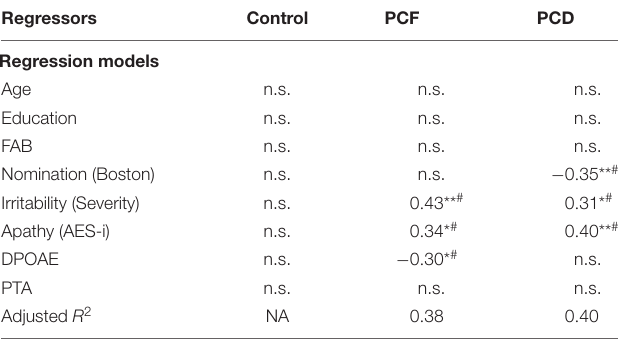
TABLE 3 | Determinants of functional impairment in the hearing status groups. Regressors Control